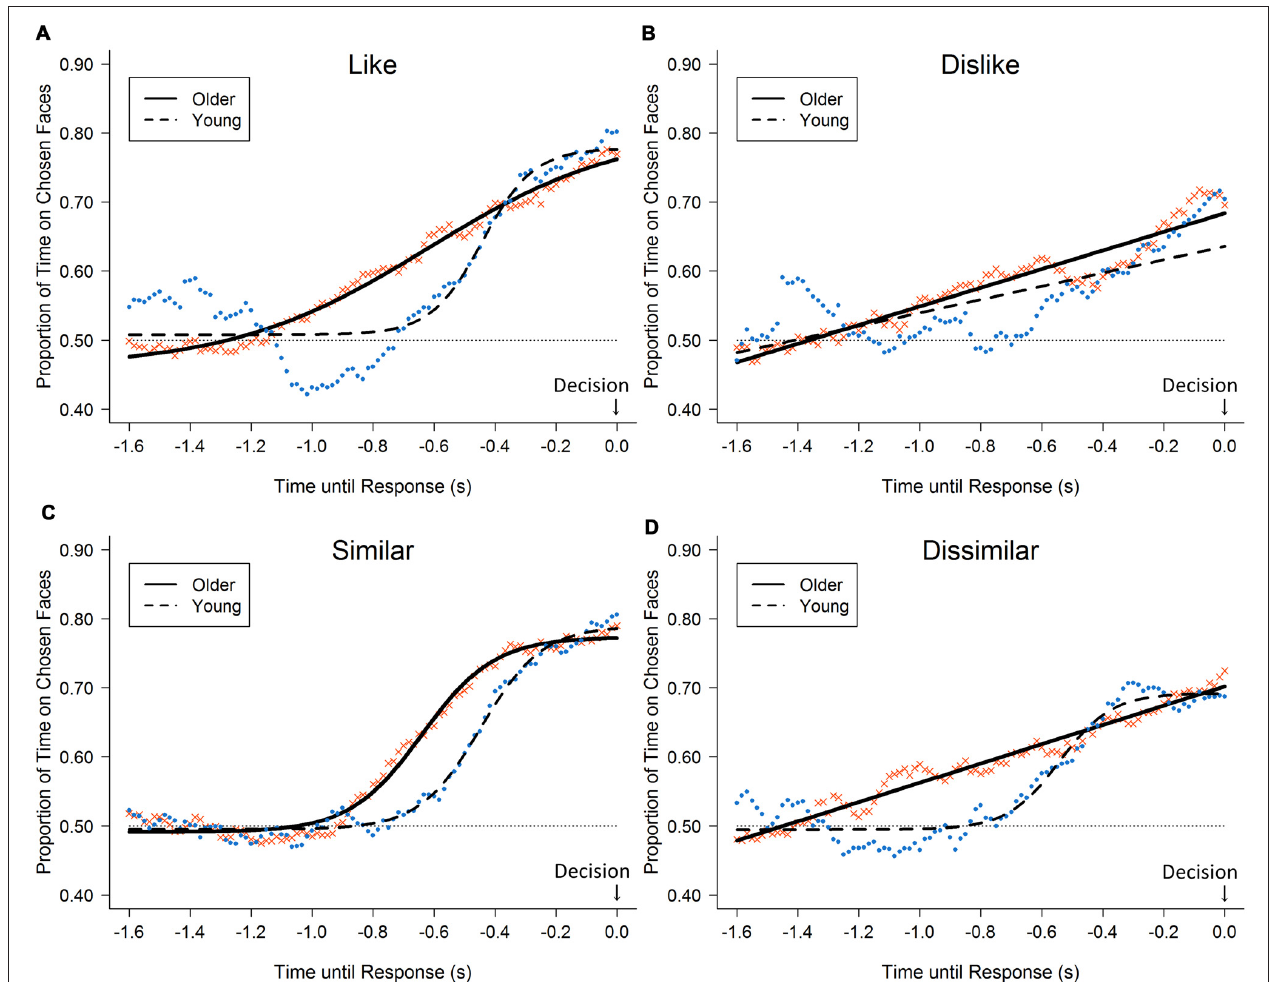
FIGURE 2 | Likelihood of gazing at the chosen face for 1.6 s before response: black circles represent the average across young adults; crosses represent older adults; lines represent fitted curves separately for younger adults (dashed lines) and older adults (solid lines). Each panel shows results for each of the four decision tasks: (A) like, (B) dislike, (C) similar, and (D) dissimilar tasks; horizontal dotted line represents the chance level